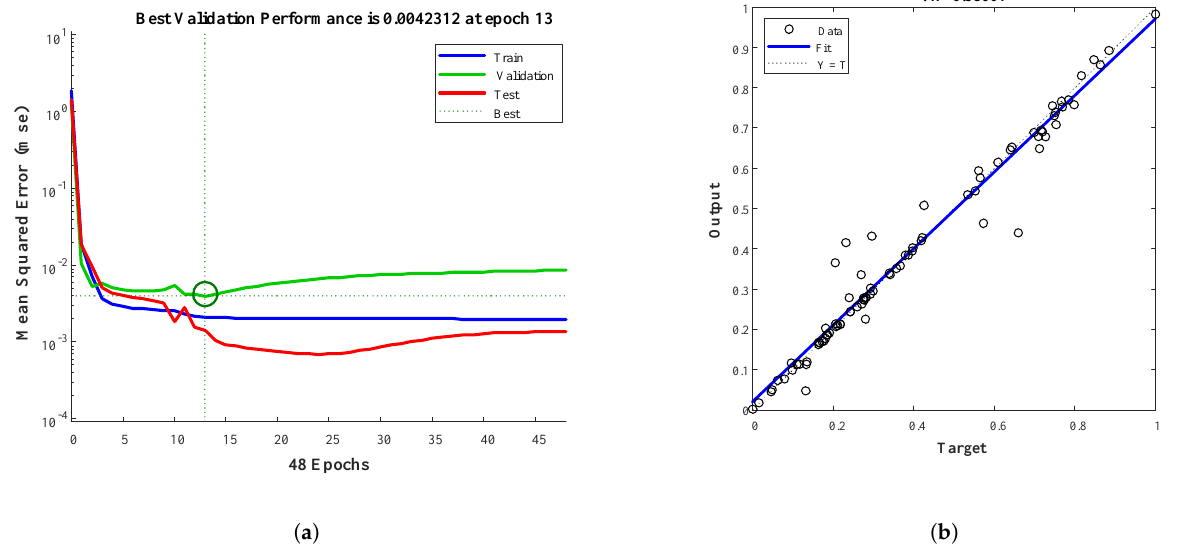
Figure 3. ( a ) The performance and ( b ) regression of the proposed network. The statistical characteristics of the reported errors, such as root mean square error ( RMSE ), correlation coefficient ( R ), mean square error ( MSE ), and mean absolute percentage error ( MAPE ), were determined for evaluating the concrete’s compressive strength by the ANN model. These errors can be calculated by Equation (3). Table 2 offers a comparison regarding these error metrics including all the analyzed datasets incorporated in the network. The zero value shows the best optimization for all statistical parameters (except for R ). On the other hand, the one value is the ideal number for R . The RMSE values shows the deviation within the empirical and predicted values. The MAPE values identify the prediction error and the ratio of the error to the empirical value [34]. The correlation coefficient is considered to assess the predictive performance of the model [35]. The statistical characteristics presented in Table 2 show that the predicted concrete’s compressive strength using ANN network is comparable to the empirical values of PFRC tests. Such comparable results highlight the functionality of the adopted ANN